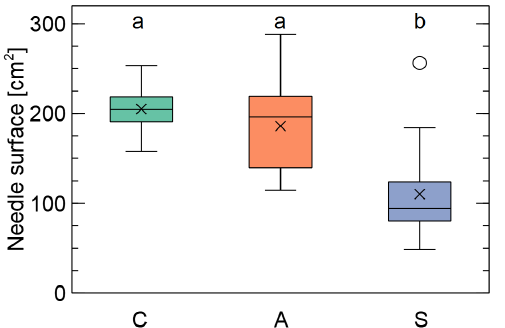
Figure 5. Changes in the needle surface of the Scots pine seedling. Three types of treatments are presented: soil amendments with phosphogypsum mixed with organic ash—A, sewage sludge—S and control—C. The lowercase Latin characters above box plots, if the same, indicate that there is no statistically significant difference between the groups at p < 0.05. In the plot, boxes span from 1st to 3rd quantile, with the median indicated by a line, whiskers indicating 1.5 inter-quantile range, the × symbol mean value, and circles outlier